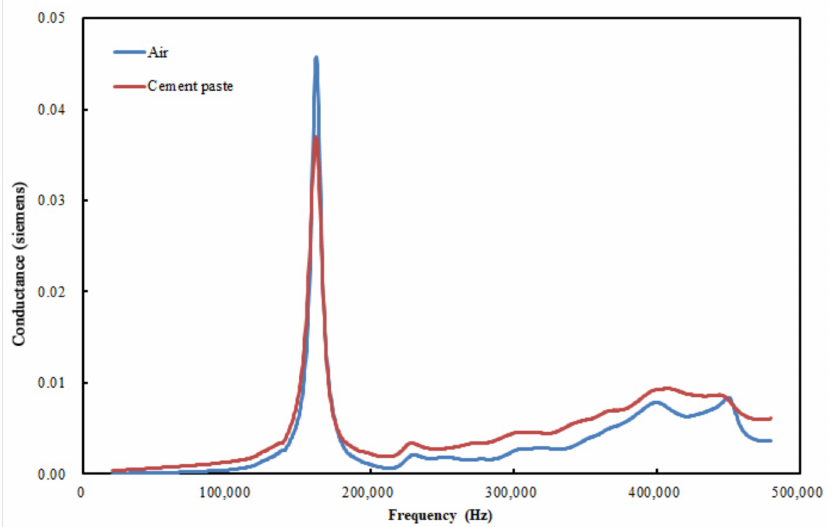
Figure 4. Conductance (real component of admittance) of PZT patch in air and in freshly mixed cement